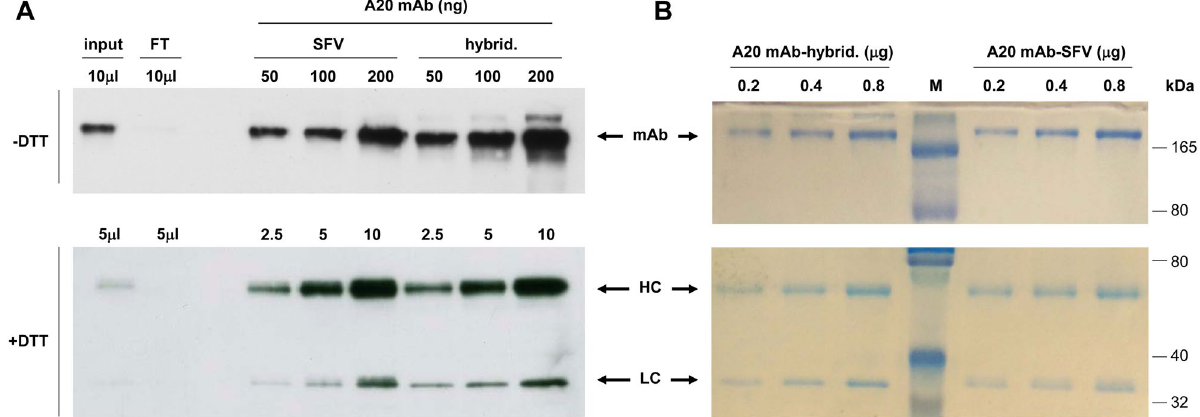
Figure 3. Purification of A20 mAb. Approximately 2 × 10 8 BHK cells harbouring ncSFV-A20-sgPr vector were incubated during a total of 60 h at 33 °C and secreted A20 mAb was purified from 1L of supernatant by affinity chromatography on a protein A-Sepharose column. Purified A20 mAb (A20-mAb-SFV) was analysed by Western blot ( A ) and colloidal blue stainining ( B ) in parallel with mAb purified from hybridoma A20 cell line (A20-mAb-hybrid.) under non-reducing (-DTT) and reducing (DTT) conditions. Input, supernatant loaded into the column; FT, column